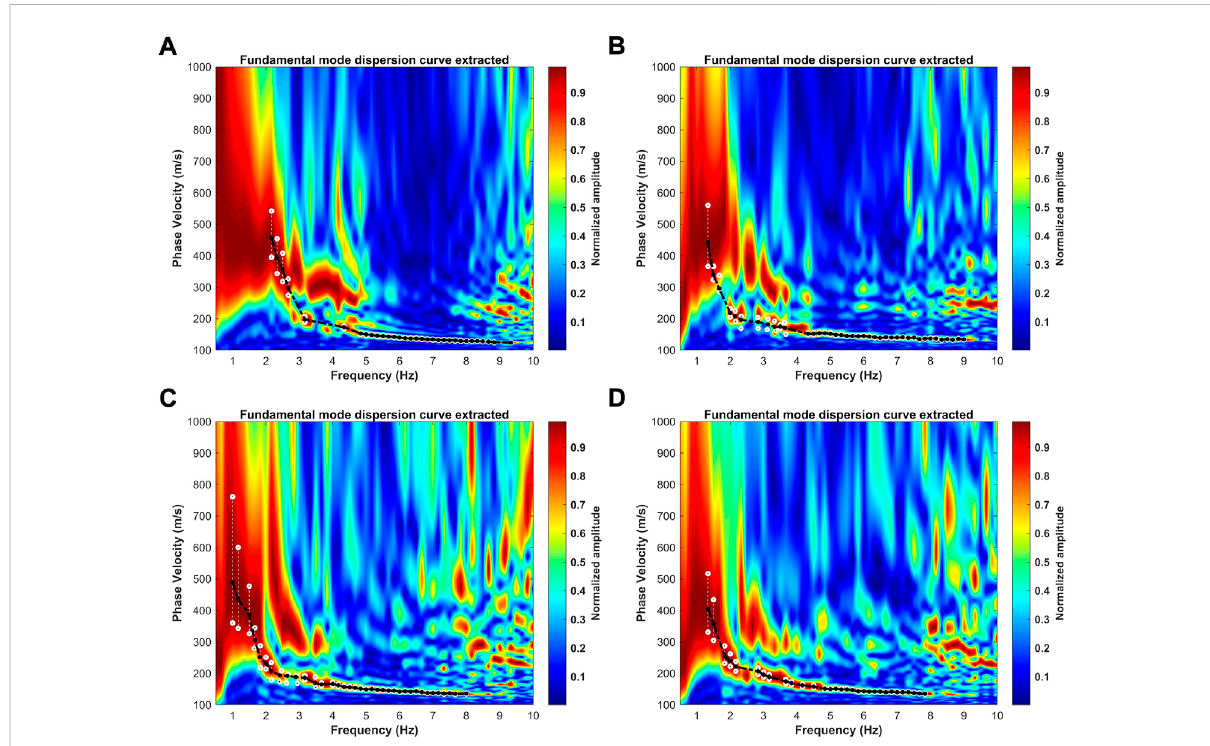
FIGURE 11 Dispersion images from the virtual gathers at Channel 11 (A) and Channel 175 (B) in Line I, and at Channel 51 (C) and Channel 200 (D) in Line II, respectively. The black curves with solid circles are the extracted fundamental model dispersion curves for inversion. The while open circles denote the upper and lower boundaries by setting as 95% of the peak